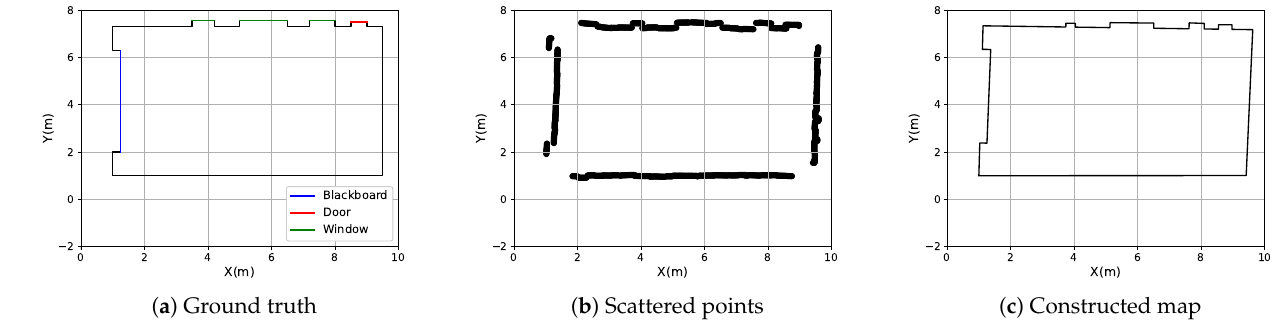
Figure 11. Classroom construction process. ( a ) represents the real indoor plan. ( b ) represents the collected wall coordinate points. ( c ) represents the indoor plan constructed by the map refinement algorithm.